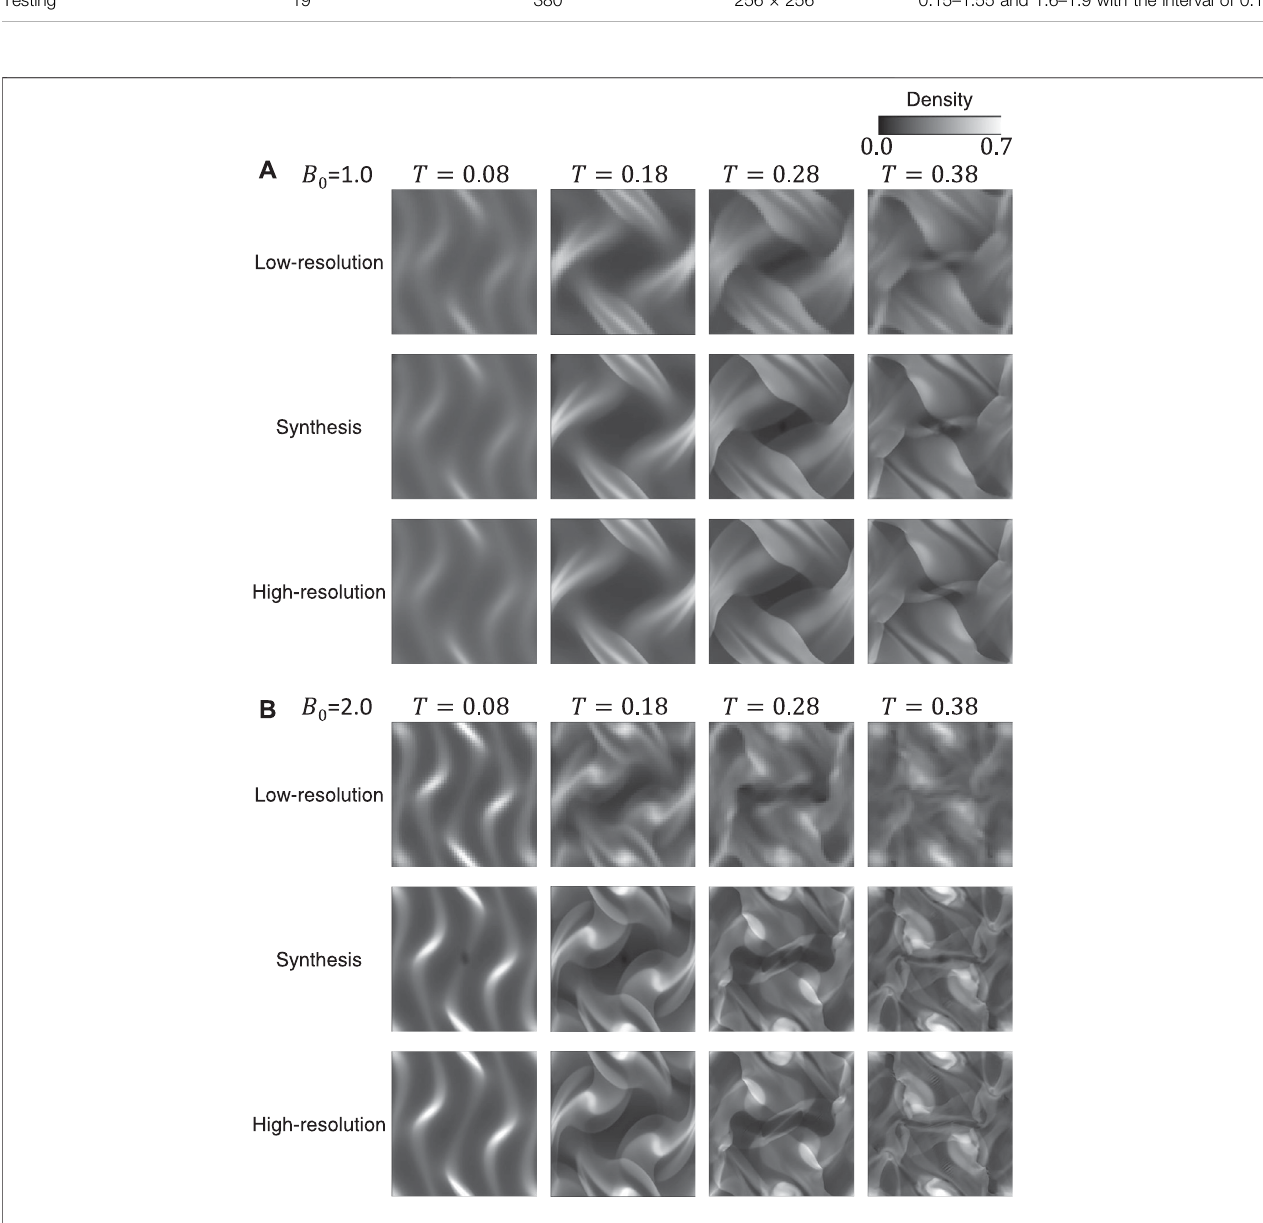
FIGURE 6 | Two examples of the time-evolution of density distribution for the training datasets.